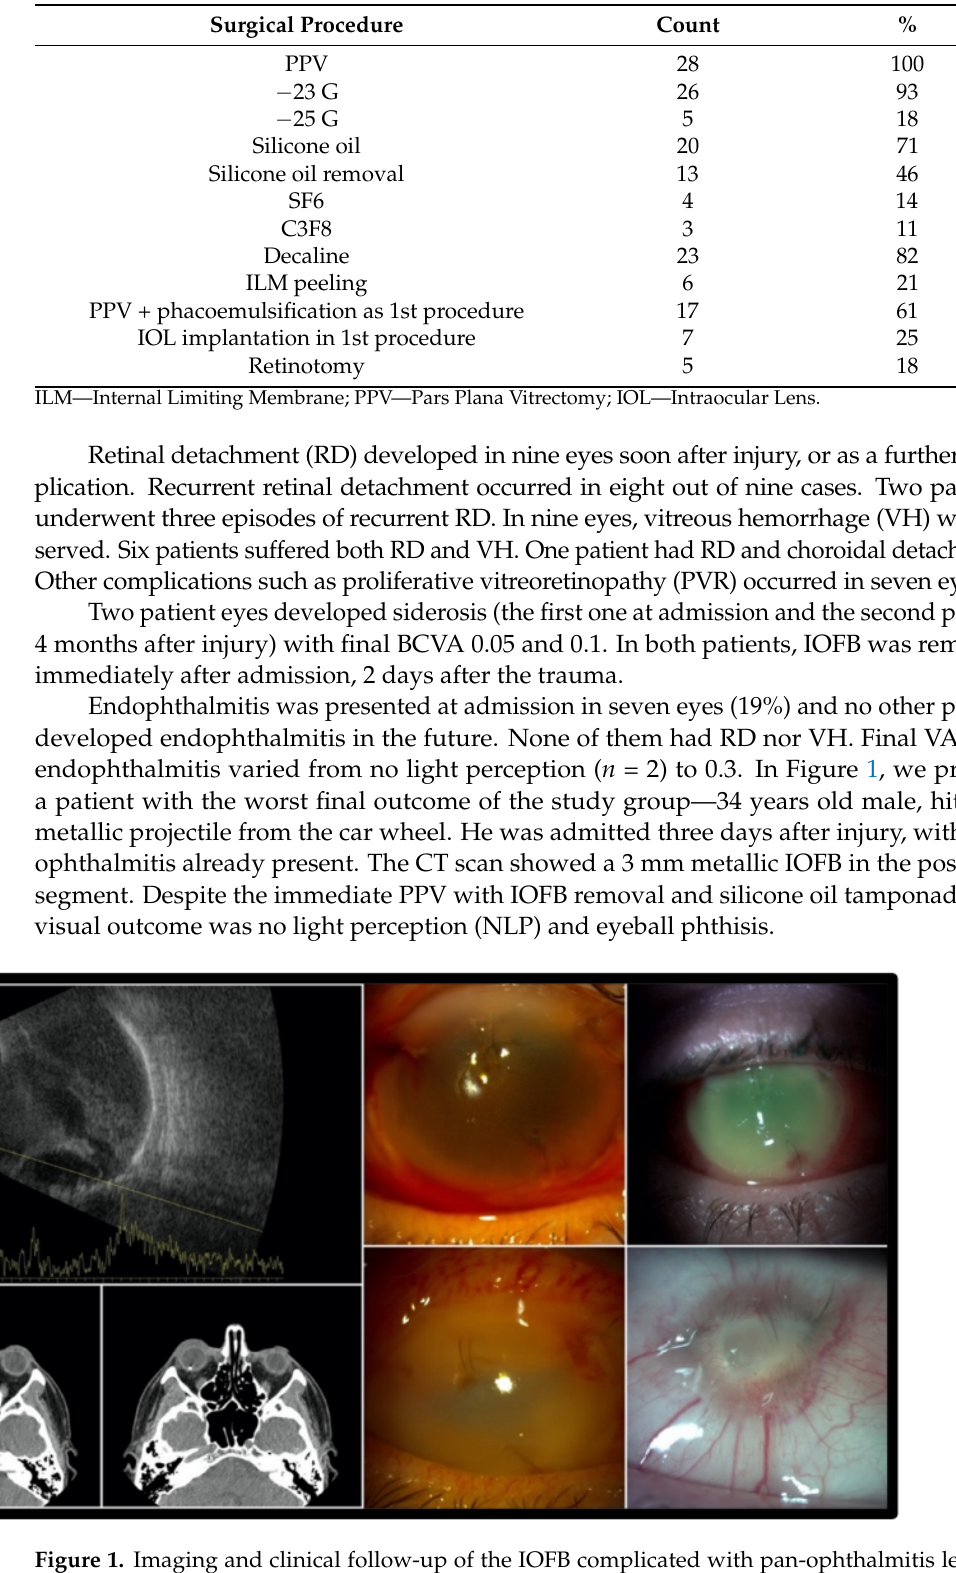
Figure 1. Imaging and clinical follow-up of the IOFB complicated with pan-ophthalmitis leading eventually to the eyeball phthisis (left side of the figure). Ultrasound examination (top left) showing dense vitreous hemorrhage and choroidal elevation. IOFB is visible as a hyperreflective signal in computer tomography (CT) (bottom left). Some patients struggled with elevated IOP (defined as higher than 21 mmHg) during treatment ( n = 16, 44%) and 31% of them had previous silicone oil tamponade ( n = 11). However, only two patients had elevated IOP at the last follow ‐ up visit, as it was managed by topical antiglaucoma medications. On the other side, seven eyes had hypotonia (de ‐ fined as the IOP lower than 6 mmHg). 3.4. Surgical Outcomes Ten injured eyes had a final BCVA of 0.4 or better (28%). Useful vision, defined as >0.1, was achieved in 21 eyes (58%). Fifteen patients had a final BCVA below 0.1, and two of them had no light perception. None of the eyes were enucleated. Identified factors associated with poor outcome are retinal detachment, proliferative vitreopathy, endophthalmitis, vitreous hemorrhage, and siderosis. Final BCVA of 0.4 or better including one or more of these factors was only experienced by four eyes. Eleven of fifteen patients with at least one risk factor had a final BCVA of less than 0.1. Visual outcomes are summarized in Table 2. Eyes with maintained silicone oil showed a poor final BCVA. Nine of eleven had a BCVA of less than 0.1. Final BCVA in eyes with traumatic cataract removal varies. Only four patients who underwent cataract surgery presented BCVA 0.4 or better. The remaining two groups, each eight eyes: first with less than 0.1 and second with more than 0.1 but less than 0.4. Patients who underwent any PPV displayed a poor final visual outcome, with 14 having a BCVA < 0.1 and 25 of 28 had a BCVA lower than 0.4. On the other hand, six of eight eyes which never had PPV showed a BCVA > 0.4.